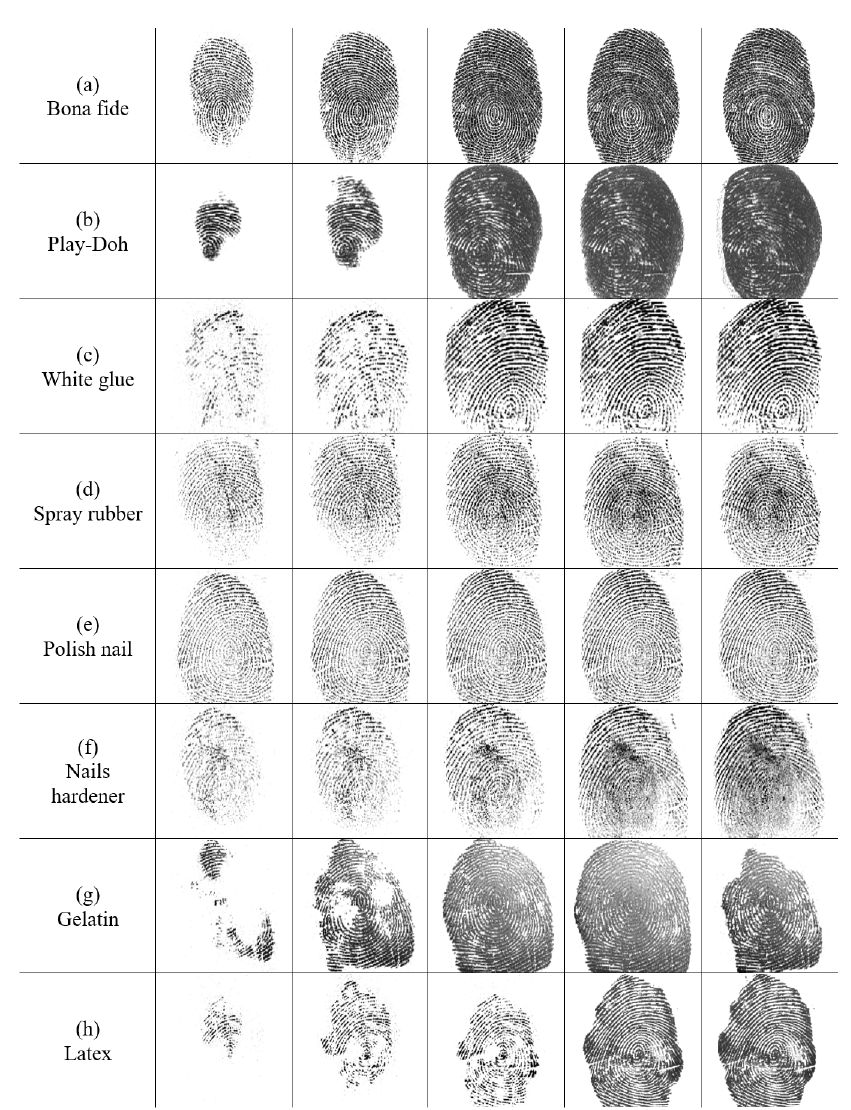
Figure 2. The influence of pressure in genuine and attack presentations. Frames are taken to demonstrate the variations at the beginning, mid, end of the presentation (left to right). The videos were captured by an optical sensor.